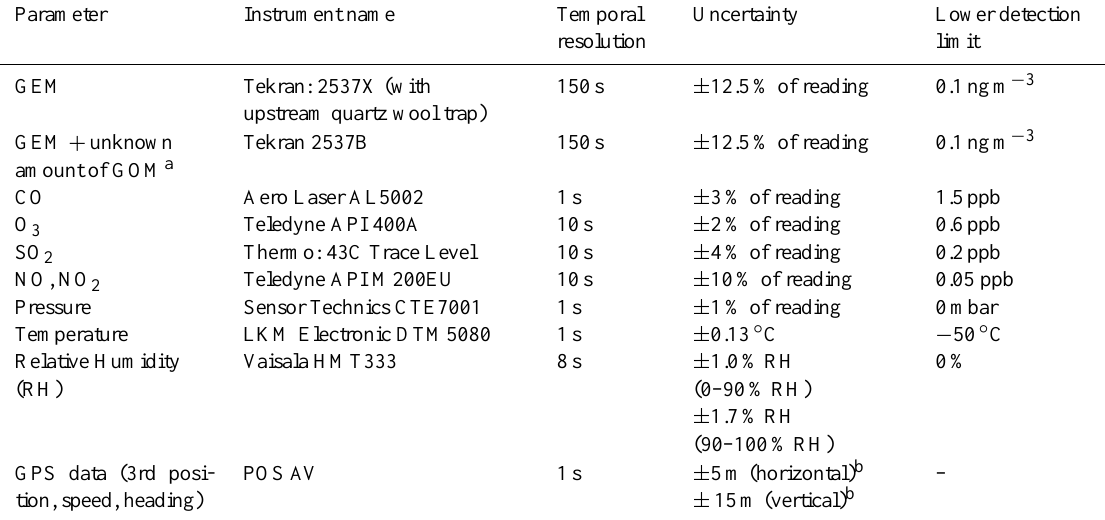
Table 2. List of instruments installed into the CASA 212 research aircraft. The acronyms are defined as GEM (gaseous elemental mercury), GOM (gaseous oxidized mercury), CO (carbon monoxide), O 3 (ozone); SO 2 (sulphur dioxide); NO (nitric oxide); NO 2 (nitric